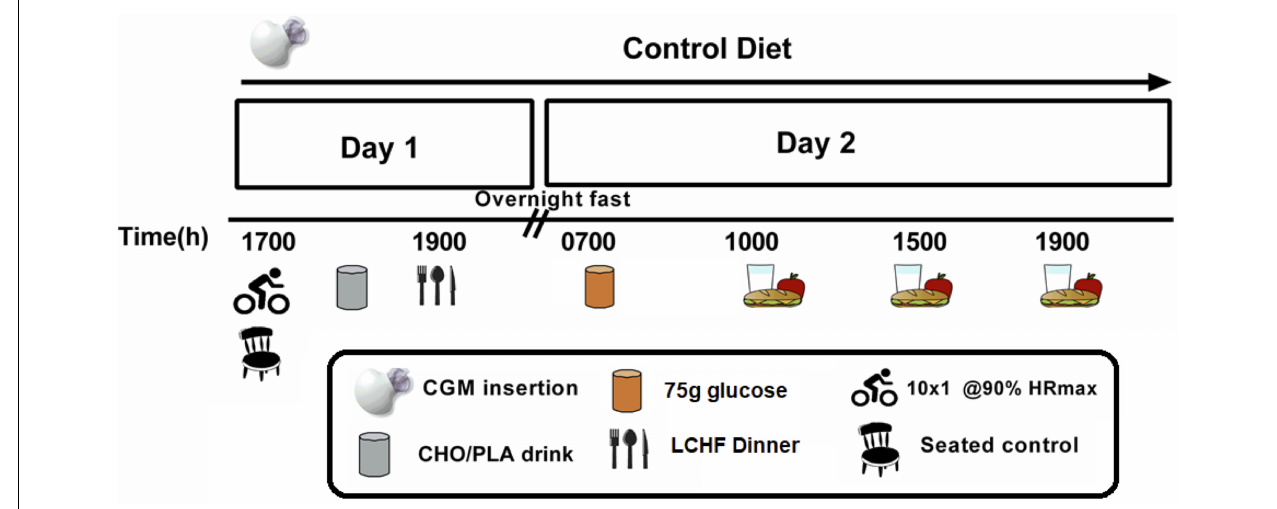
FIGURE 1 | Schematic representation of metabolic trials. A continuous glucose monitor (CGM) was worn for three 2-day trials under standardized dietary intake. At 17:00 h on Day 1, participants either sat in the laboratory (CTL) or performed low-volume HIIE (10 × 1-min cycling intervals at ∼ 90% HRmax). Following HIIE, participants consumed either a carbohydrate (CHO) drink to replenish the exercise-induced energy deficit (EX-HC) or a non-caloric placebo (PLA) drink to remain in an exercise-induced energy deficit (EX-NC). All participants consumed a low-carbohydrate high-fat (LCHF) dinner that evening. Glycemic responses to the following day’s meals, and over a 24 h period (from 00:00 to 23:59 h), were determined via